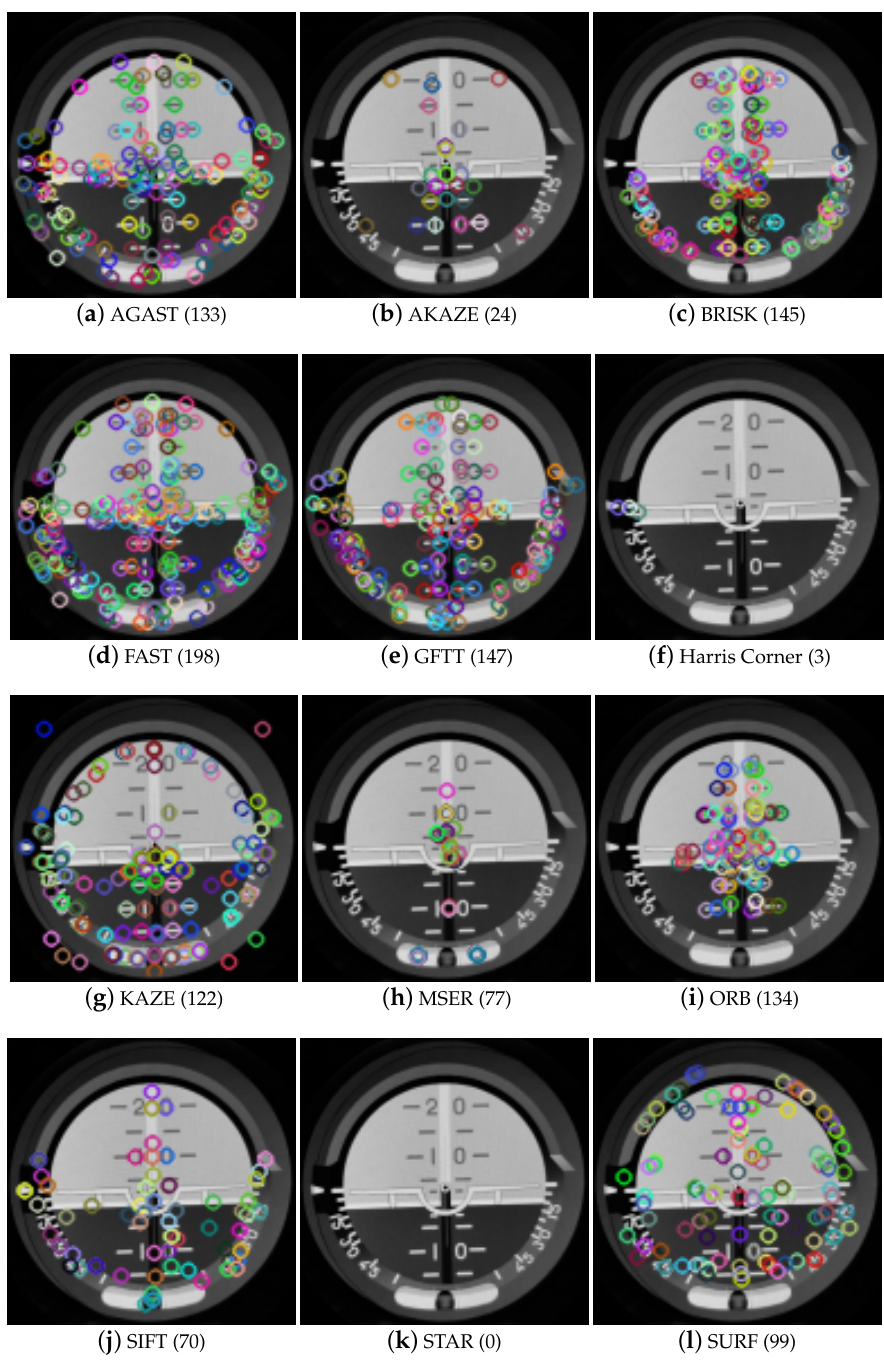
Figure 4. Presentation of the locations of detected characteristic keypoints. The number in the brackets gives the number of locations